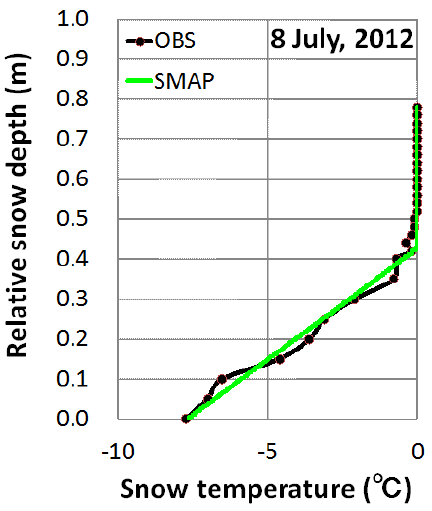
Figure 6. Comparison of snow temperature profiles in the NSL at the SIGMA-A site between snow pit observations (OBS) and pro- files simulated with the SMAP model at 11:30UTC on 8 July 2012. Relative snow depth denotes the height of the NSL above the thick bottom layer of ice. The snow depths simulated by the SMAP model were adjusted to the measurements.